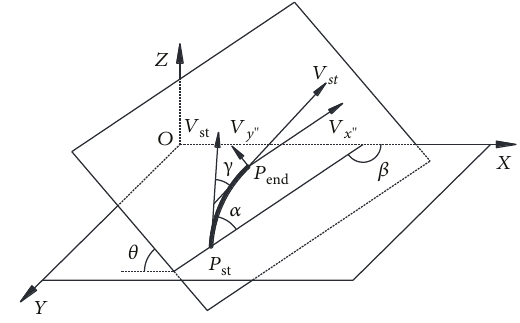
Figure 6: Analysis of uniform circular motion in three